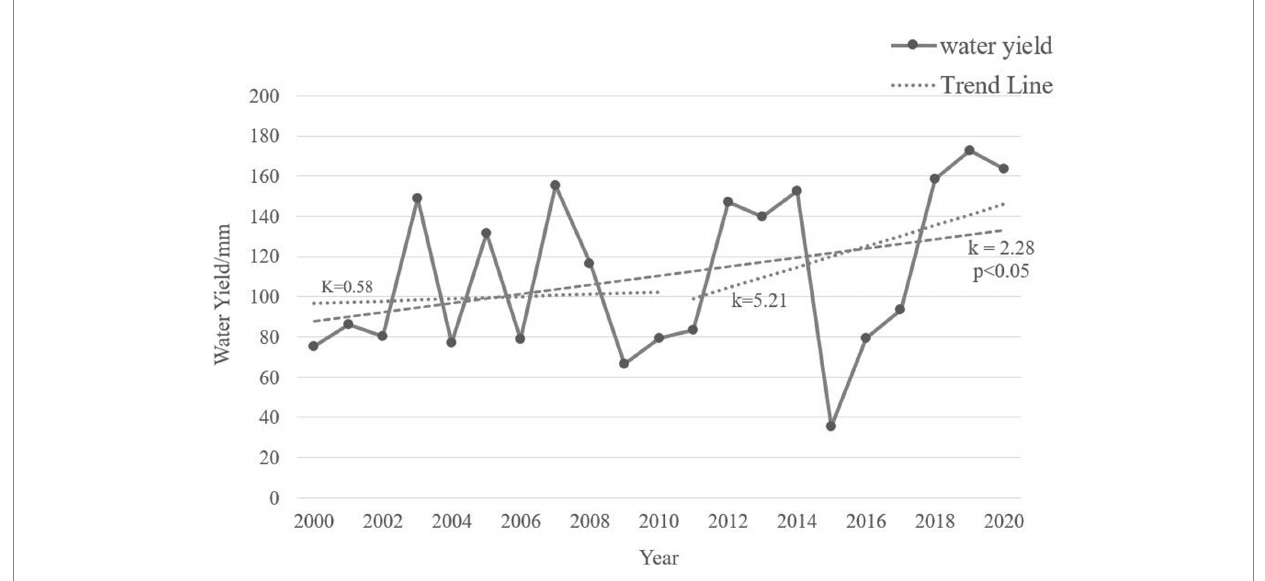
FIGURE 3 Inter-annual changes of WYs in AEGC from 2000 to 2020. The black solid line is the WYs, and the dotted line is the change trend of